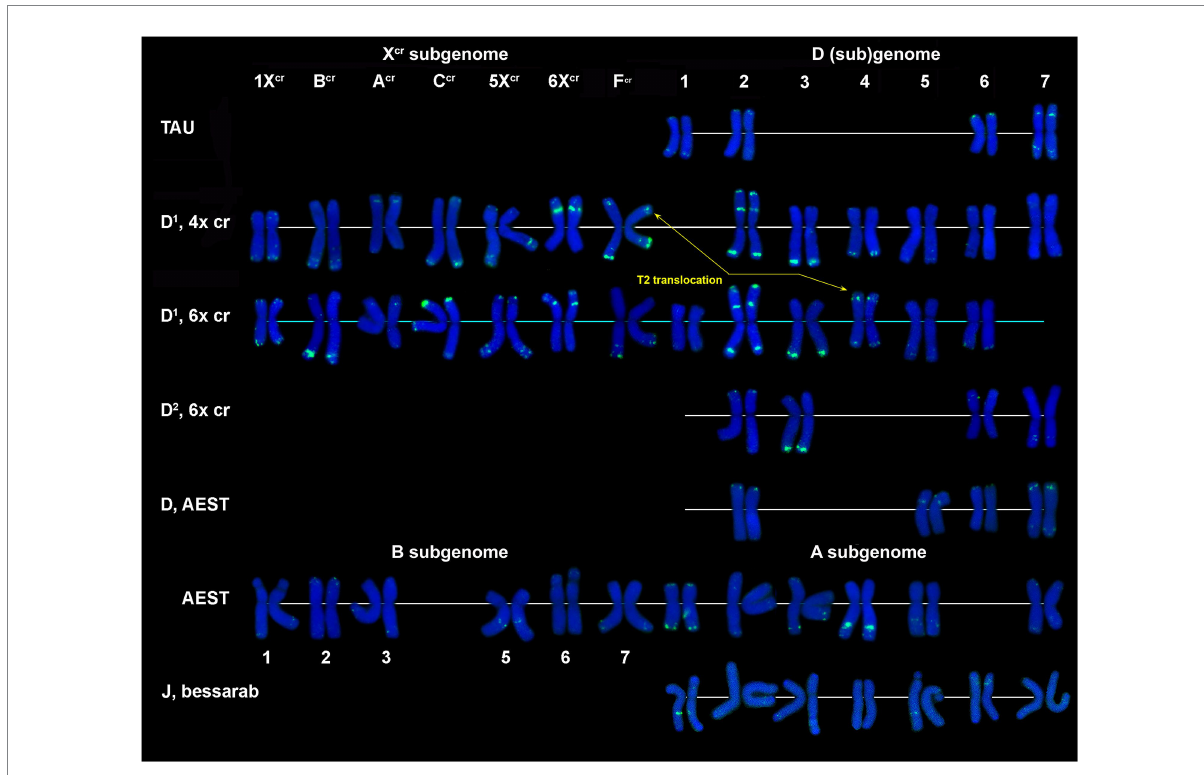
FIGURE 7 Comparison of CL131 labeling patterns on chromosomes of different cereal species: TAU – Ae . tauschii ssp. strangulata; D 1 , 4x cr – D 1 subgenome of tetraploid Ae . crassa ; D 1 , 6x cr, D 2 , 6x cr – D 1 and D 2 subgenomes of hexaploid Ae . crassa; AEST – A, B, and D subgenomes of T . aestivum ; J, bessarab – J b genome of Th . bessarabicum . 1–7 – homoeologous